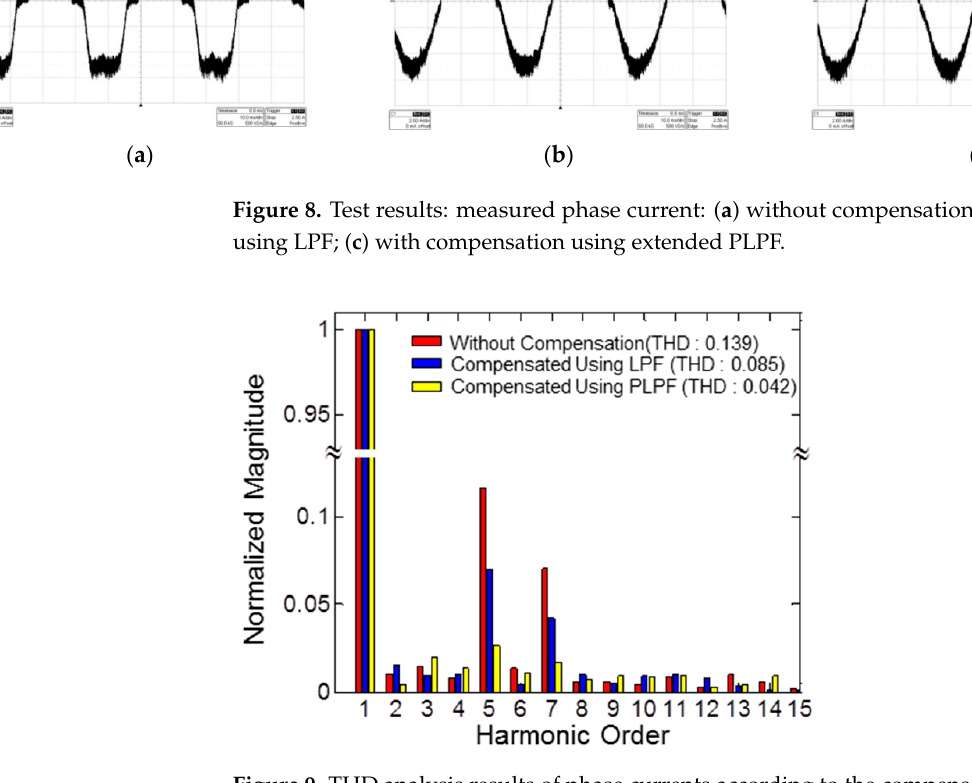
Figure 10. Comparison of signal flows between conventional PLPF and extended PLPF for dead-time compensation. Figure 11 shows d- and q-axis current during start-up tests. The distortion of phase current results in d- and q-axis current ripples. As shown in Figure 11b, the proposed PLPF can be effectively applied during the start-up and transient state. However, for the transient performance, the fractional value K between the cut-off frequency and syn- chronous frequency in Equation (10) should be carefully determined. If higher speed dynamics is required, a smaller value of K should be selected.